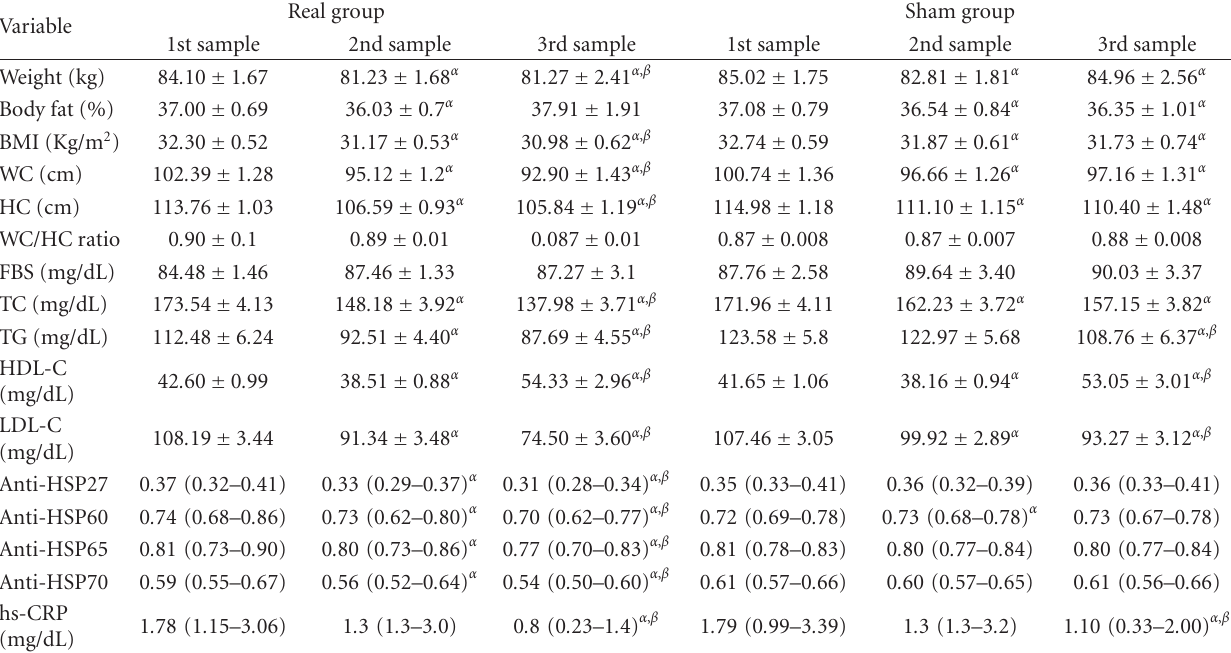
Table 2: Comparison of clinical and biochemical characteristics of participants of body